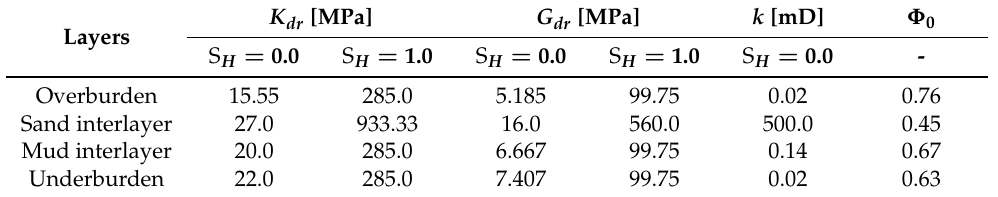
Table 1. Material properties for flow and geomechanics in each type of layer for the simulation.